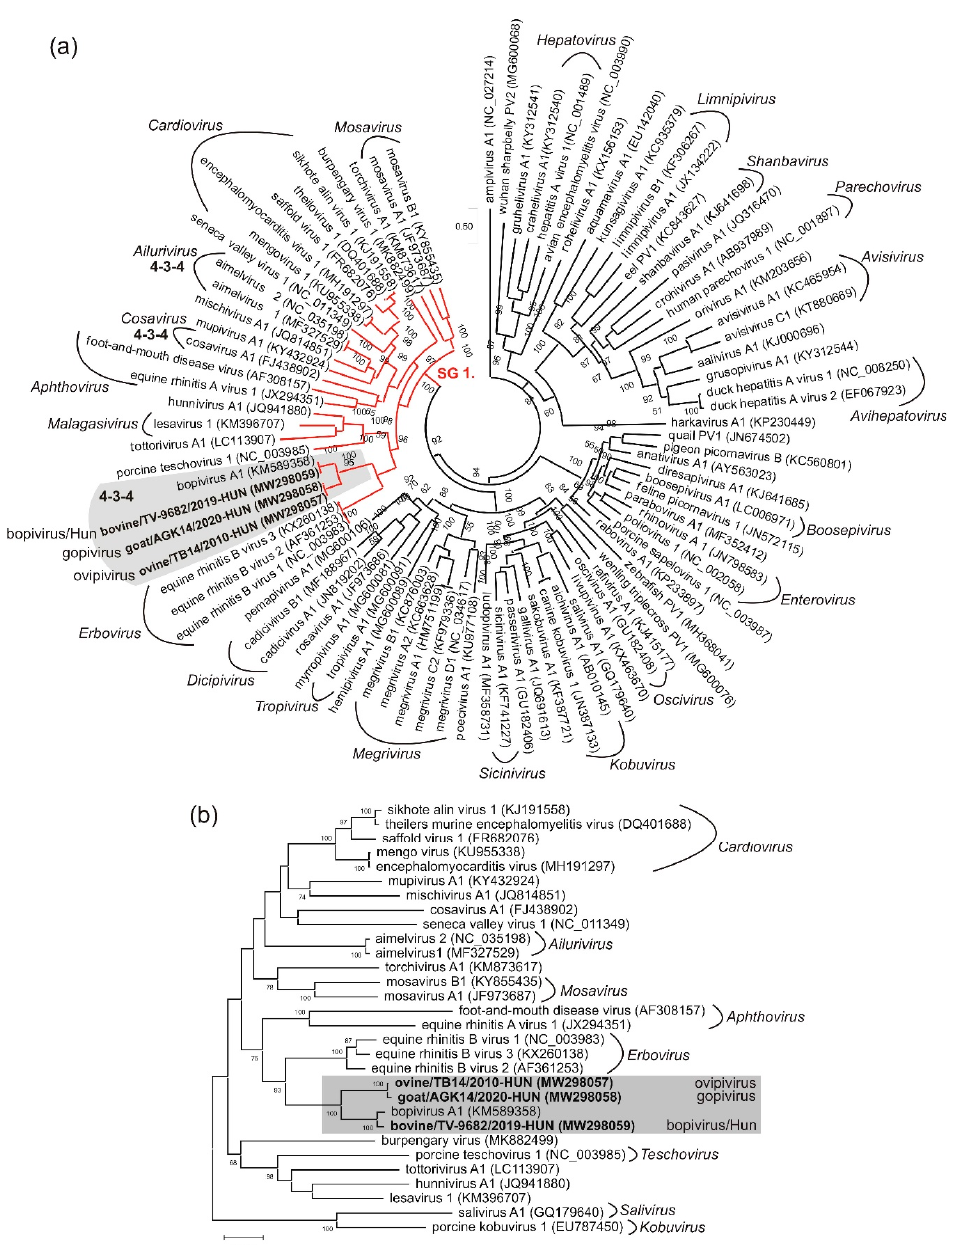
Figure 4. Phylogenetic analyses of the study ovipi-, gopi-, bopiviruses (in bold ) and the representative members of family Picornaviridae based on the amino acid alignments of 3CD ( a ) and P1 ( b ) genomic regions. The trees are constructed using the Maximum likelihood method and either LG + F + I + G4 (a) or Jones Taylor Thornton (b) amino acid substitution models with 1000 iterations (bootstrap). The phylogenetic position of genus Bopivirus is marked with a grey background. The lineages of supergroup 1 (SG1) in the 3CD tree are marked with red lines. 4-3-4 indicate the genera in SG1 where picornaviruses with 4-3-4 genome organisations are present. The locations of some genera are shown in italics to help the orientation. A representative member of genera Sali- and Kobu-virus were used as outgroups in the P1 phylogenetic tree.